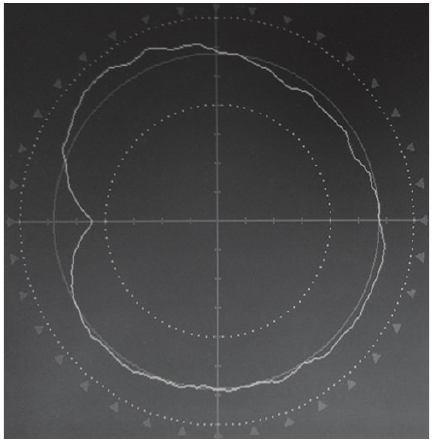
Figure 8: Out-of-roundness measurement results on premachined 34-CrNiMo6 steel. Ra5.6 and PV value 20.0 𝜇 m.